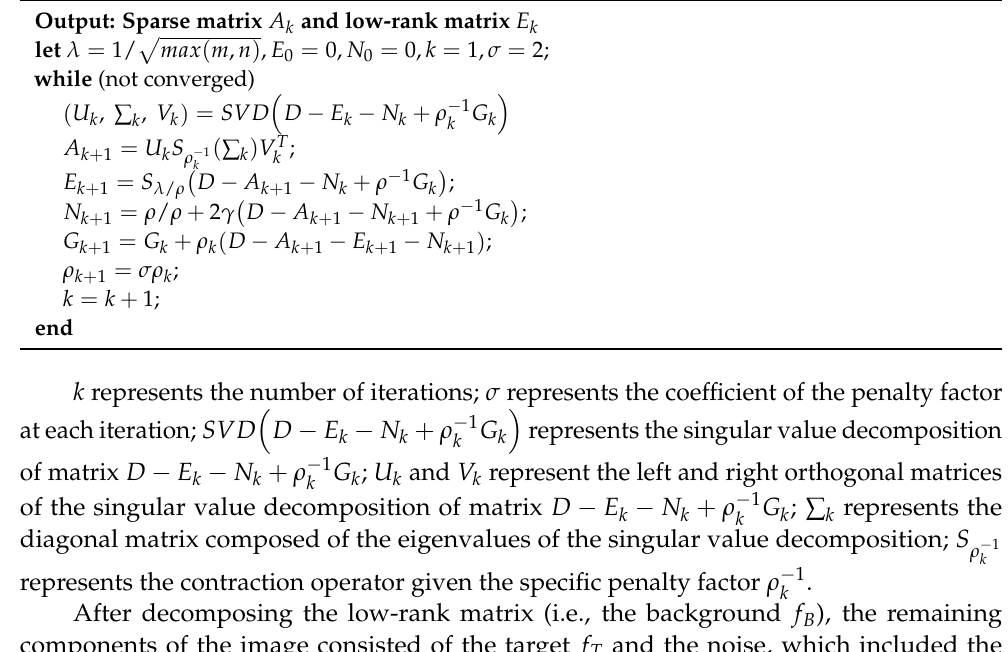
Algorithm 1 The pseudocode of ADMM.